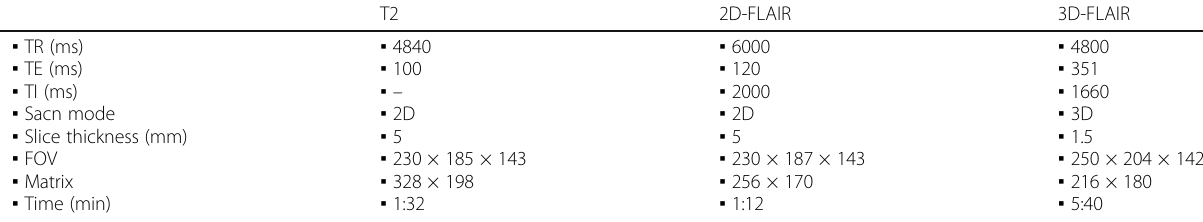
Table 1 MRI pulse sequences used in this study T2 2D-FLAIR 3D-FLAIR